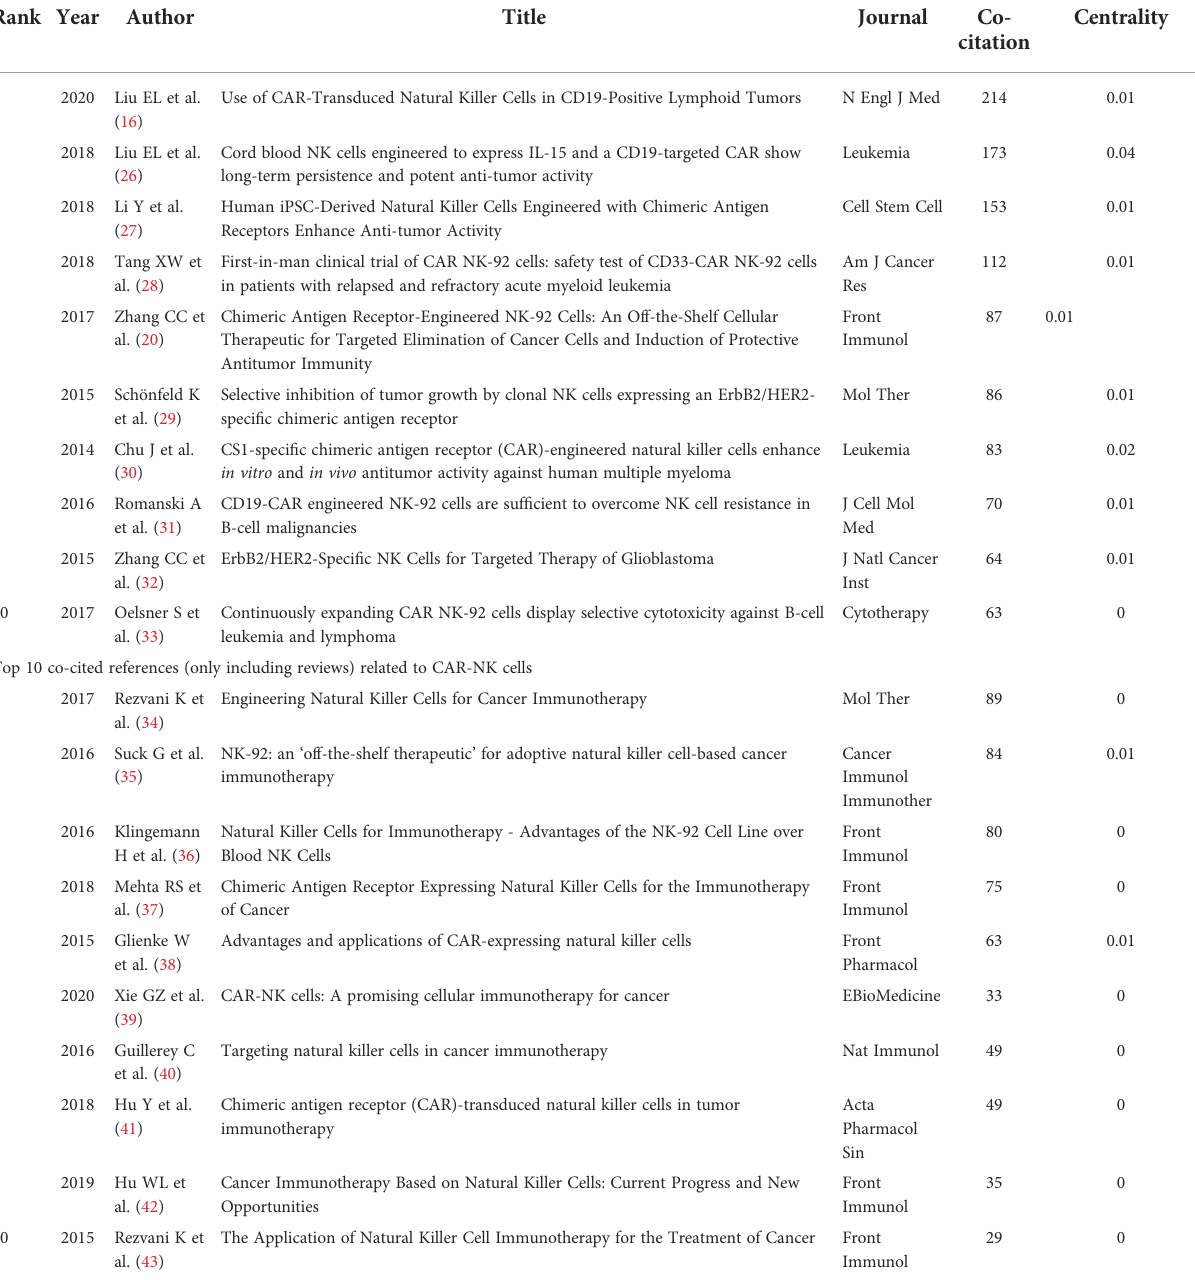
TABLE 5 The top 10 co-cited references related to CAR-NK cells. . Top 10 co-cited references (only including articles) related to CAR-NK